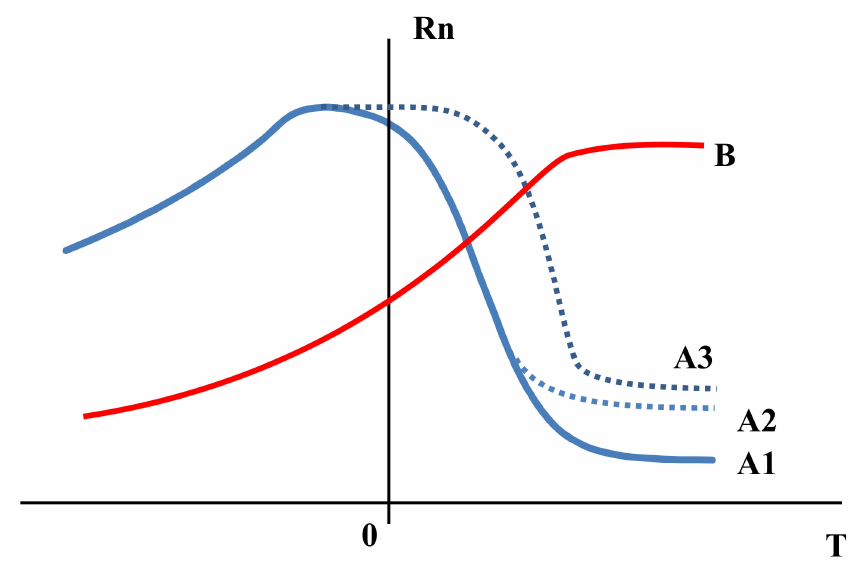
Figure 5. Schematic presentation of patterns and subtypes of radon concentration dependence on outdoor temperature.